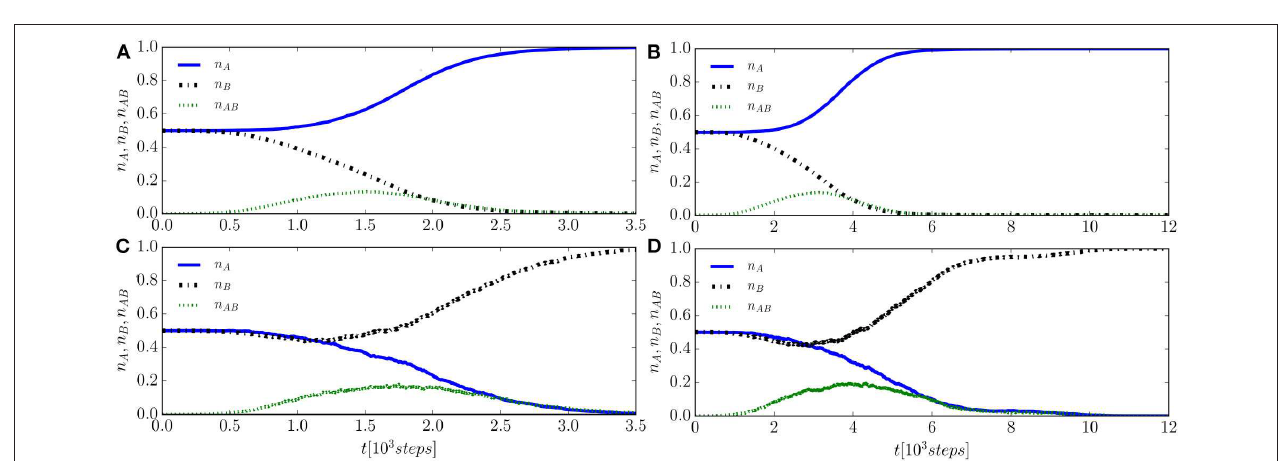
FIGURE 10 | Population fractions n A ( t ), n B ( t ), and n AB ( t ) vs. time, starting from SIC; results are obtained by averaging over 600 runs. Left column (A,C) : a system with N 100 agents can reach consensus with name A (A , about 91 % of runs) or name B (C , about 9 % of runs). Right column (B,D) : system with N = reaching consensus with name A in about 96 % of runs (B) and with name B in about in the remaining 4% of runs (D) .